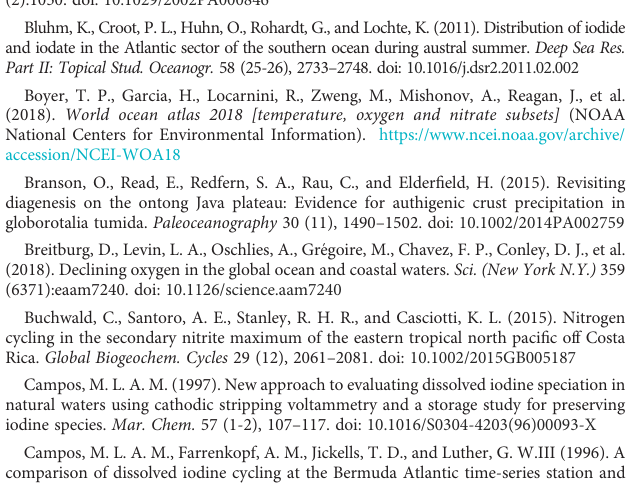
SUPPLEMENTARY FIGURE 1 CTD bottle pro fi les of iodate (circles) and dissolved oxygen (diamonds) concentrations from the station South Benguela. SUPPLEMENTARY FIGURE 2 CTD bottle pro fi les of iodate (circles) and dissolved oxygen (diamonds) concentrations from the station North Benguela. SUPPLEMENTARY FIGURE 3 More CTD bottle pro fi les of iodate (circles) and dissolved oxygen (diamonds) concentrations from the station North